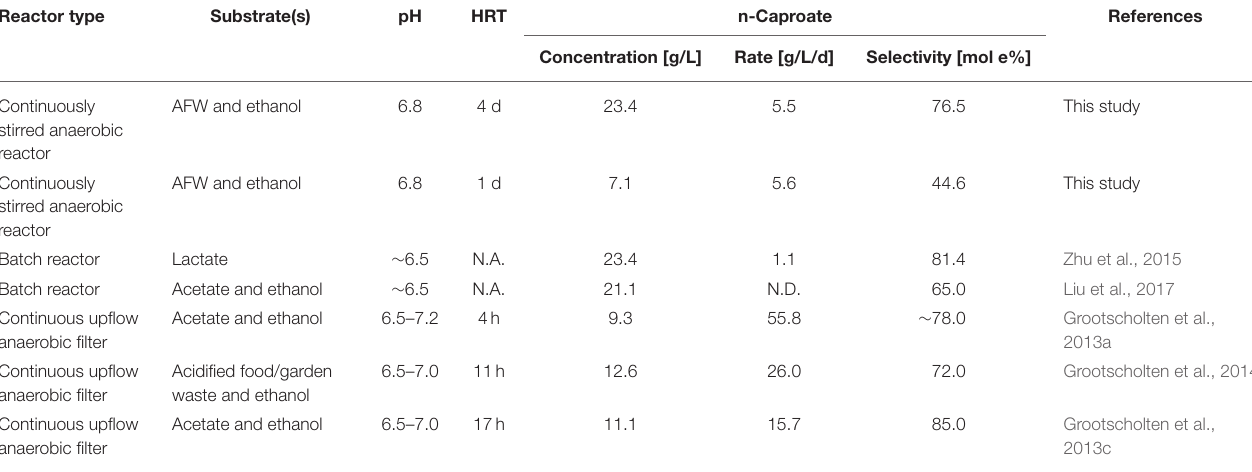
TABLE 2 | Overview of comparable studies that report high n-caproate concentrations and/or rates using open cultures. Reactor